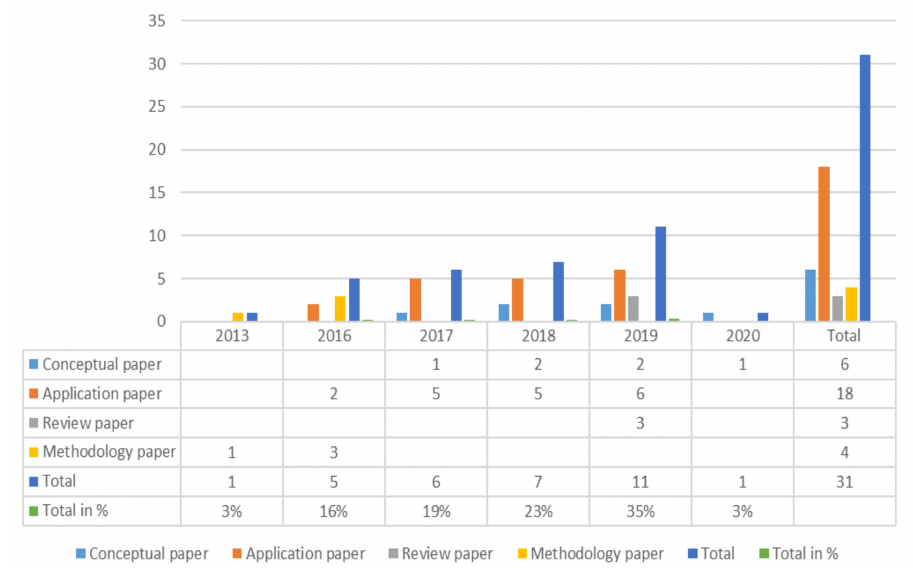
Figure 4. Distribution of the type of papers as a function of the publication year (source: Scopus).